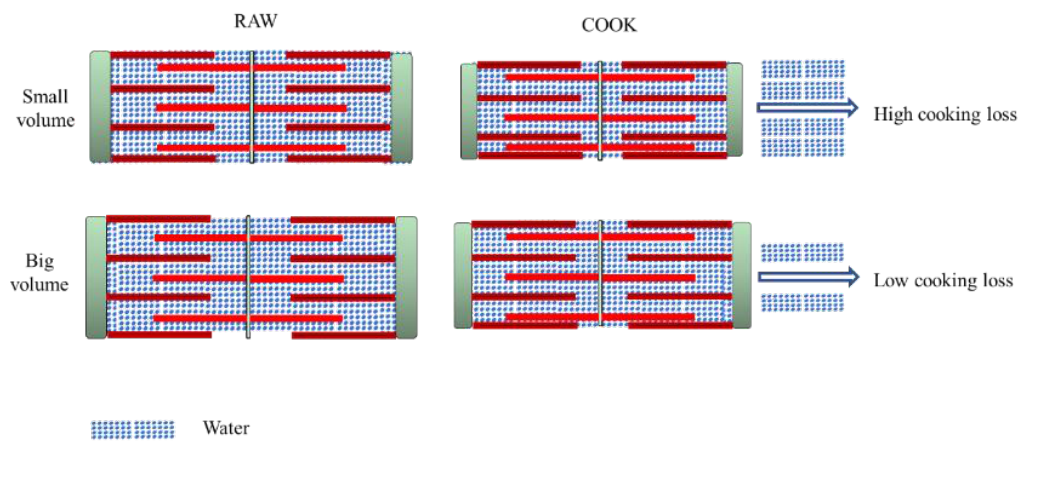
Figure 3. Comparison between cooking loss of different porcine muscles.